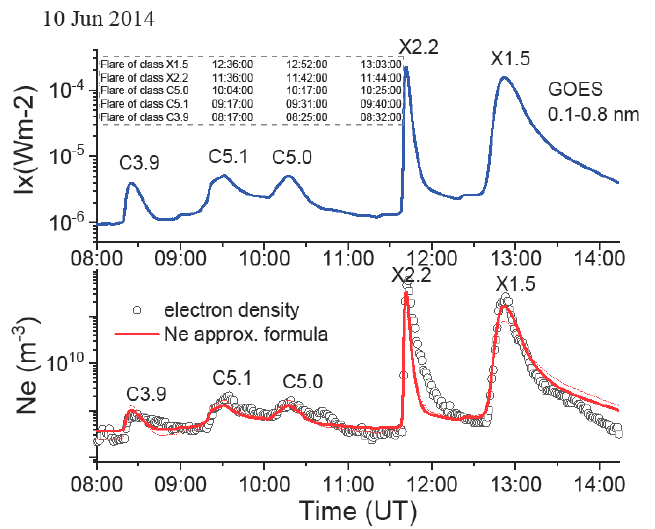
Figure 10. Variation of X-ray flux, as measured by GOES-15 satellite, and the corresponding electron density evaluated at reference height 74 km versus universal time UT during five successive flares on 10 June 2014. The red line presents results obtained using simple approximative Equation (3). With circles are presented Ne obtained by the mentioned above method. To enable the better and more adequate use of data, we give electron density results